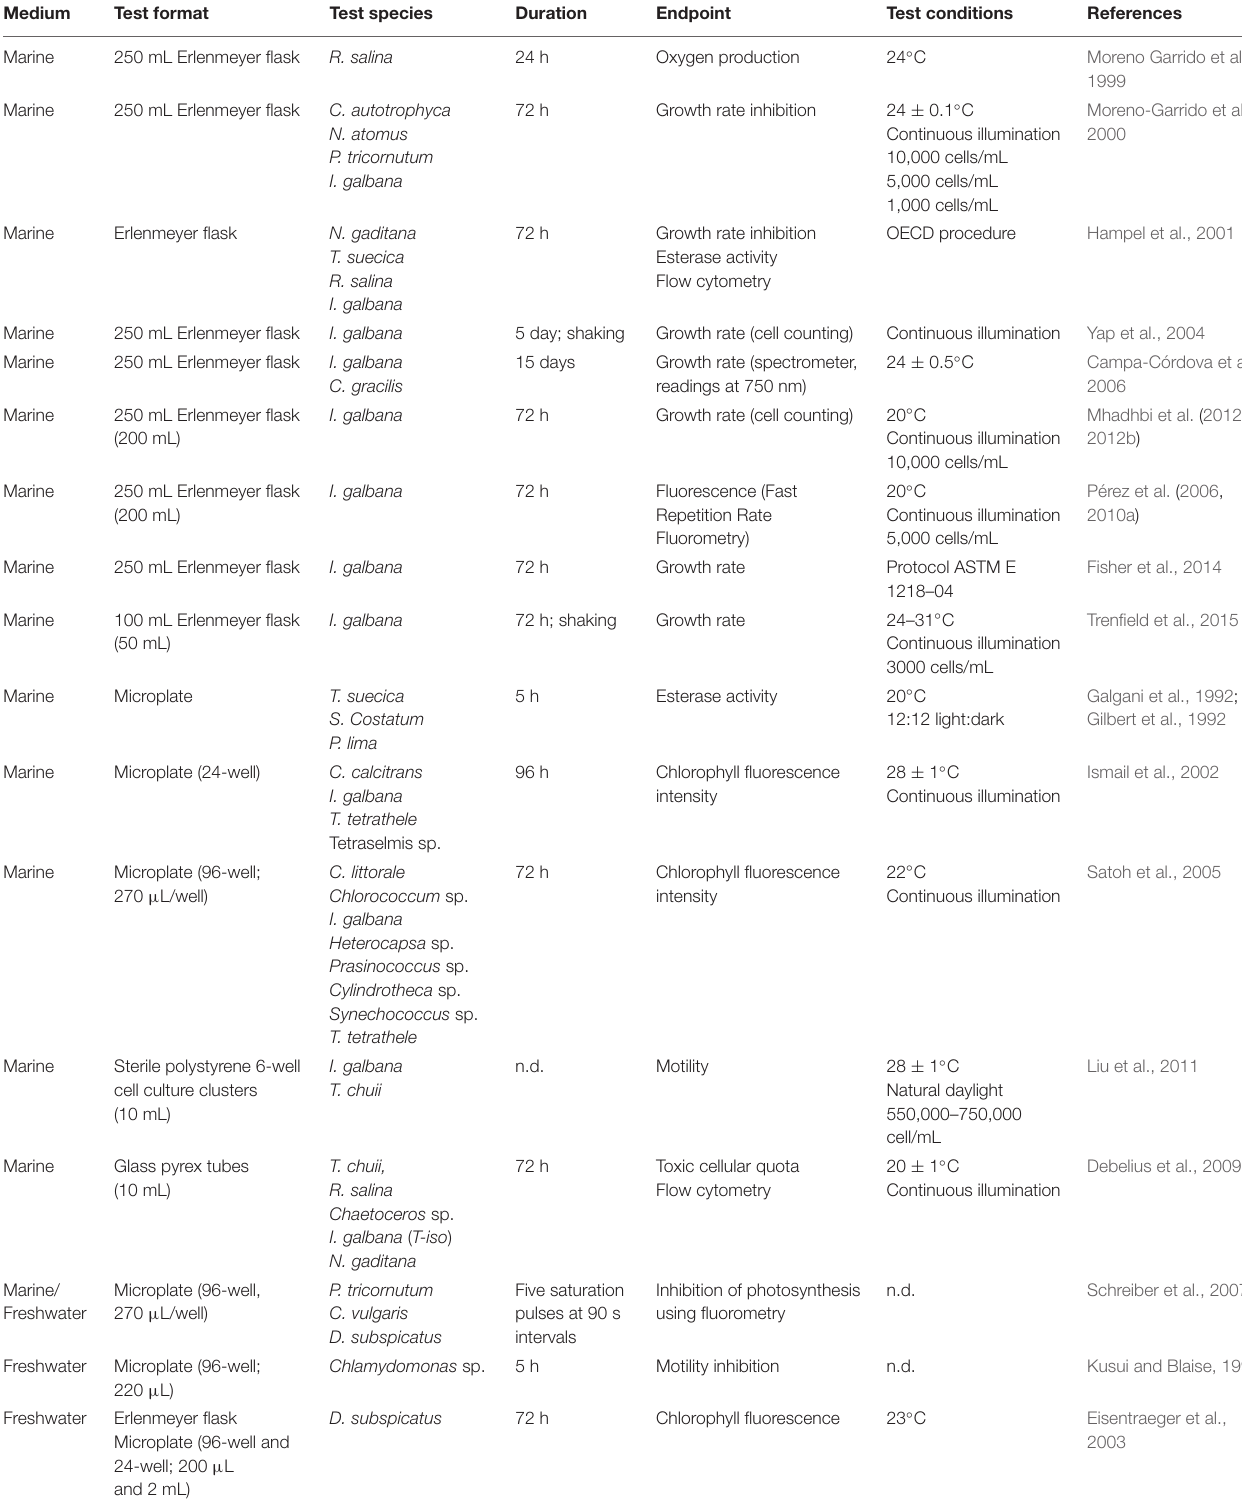
TABLE 3 | Overview of algal toxicity test conditions established by different